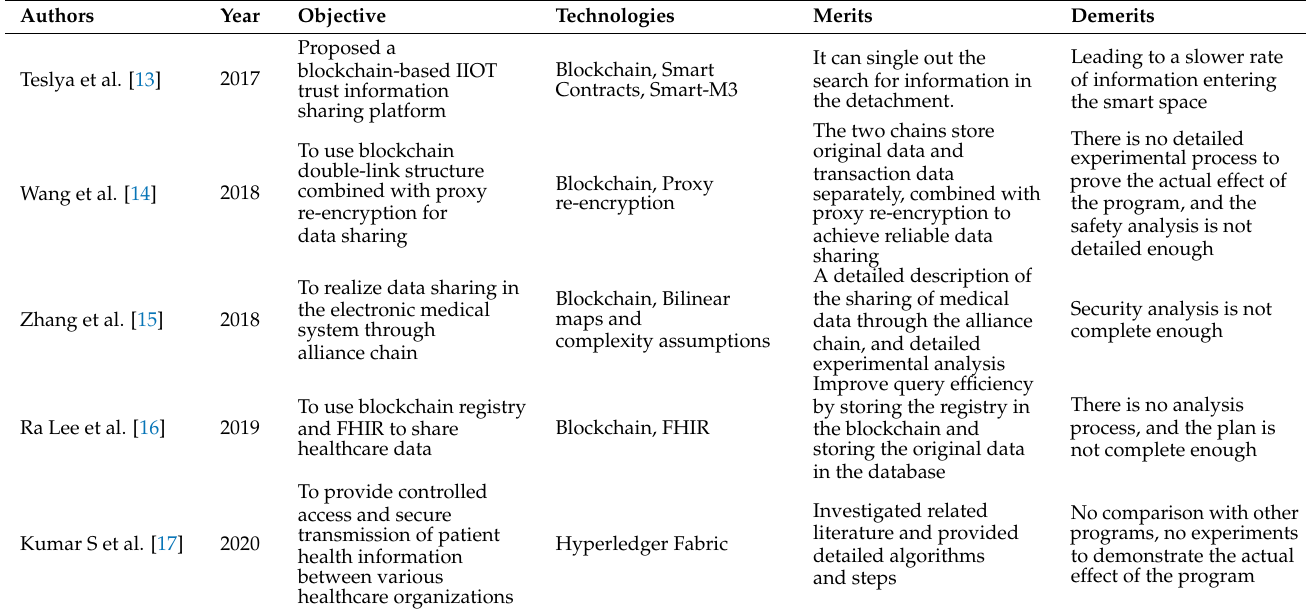
Table 1. Comparison between the proposed and existing enterprise data sharing